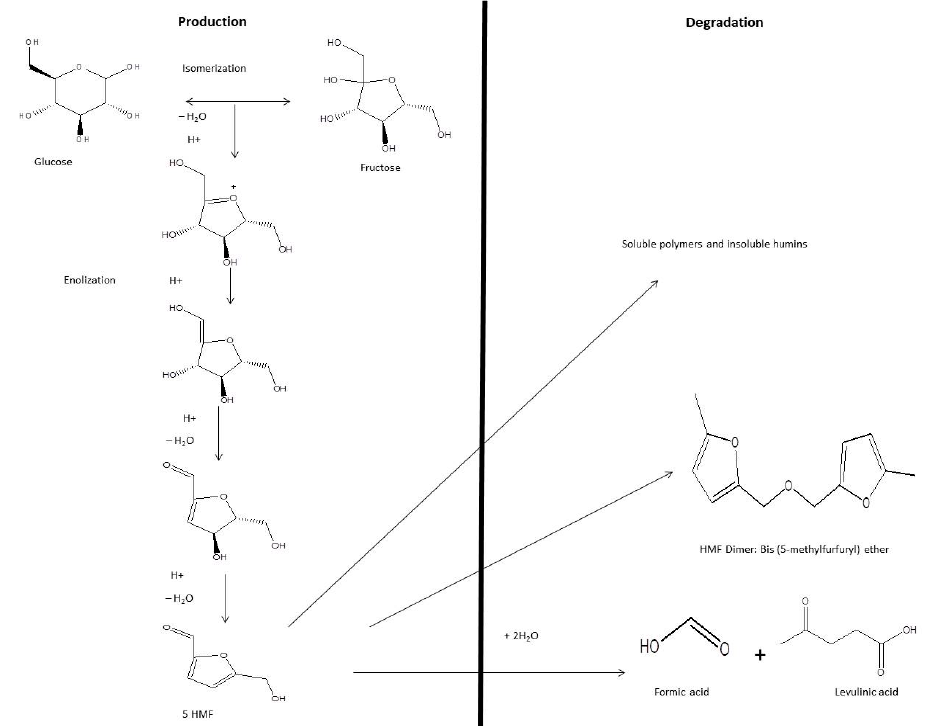
Figure 5. Production and degradation of HMF in honey